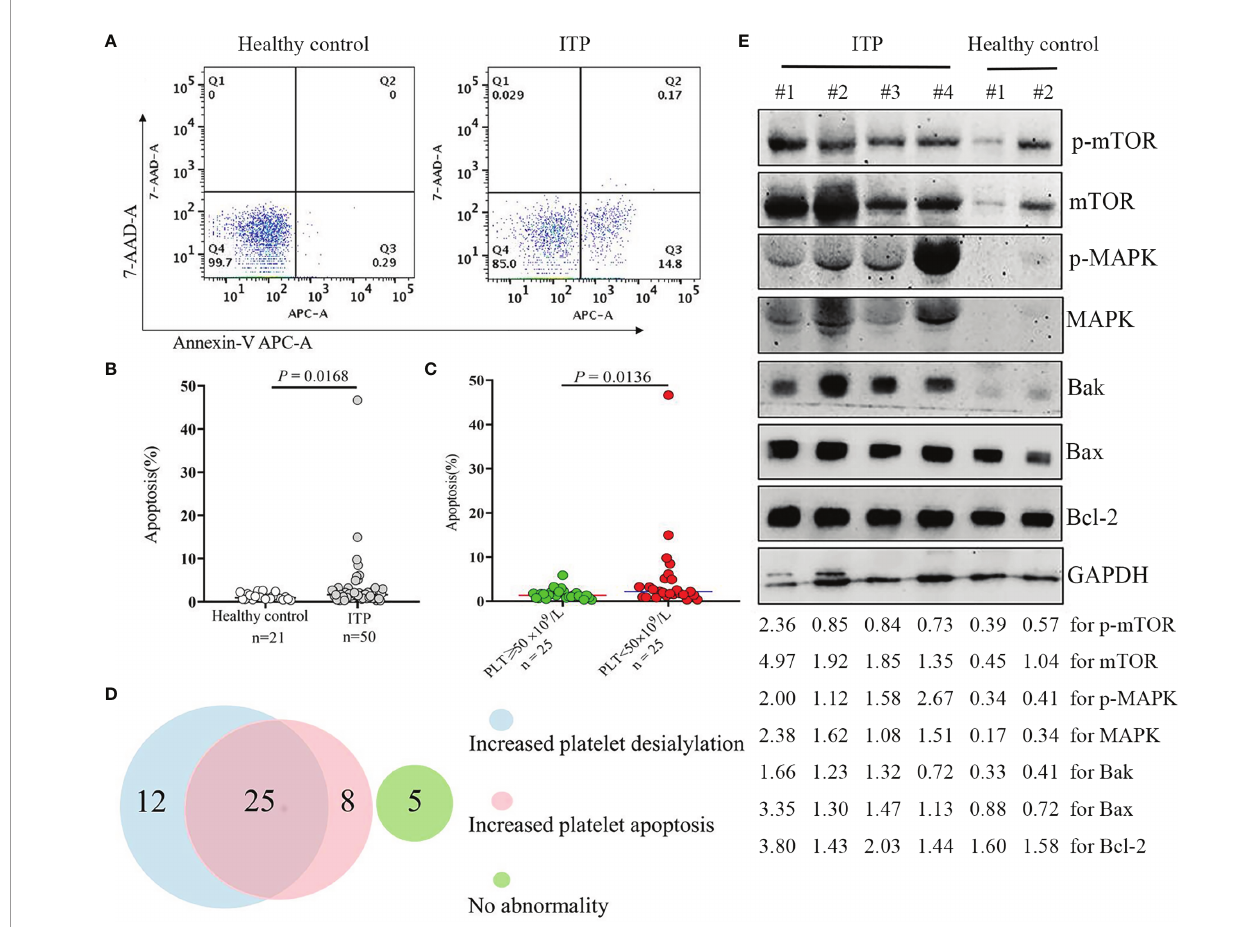
FIGURE 5 | Platelet apoptosis in the ITP cohort. Apoptotic platelets were stained with Annexin V-APC/7-AAD, and analyzed by fl ow cytometry. (A) The representative dot plots from healthy controls and ITP groups are shown. (B) Comparison of platelets undergoing apoptosis in healthy controls and patients with ITP. The P- value was calculated using the Mann-Whitney test. (C) Comparison of apoptotic platelet levels in ITP patients with different platelet count. (D) Venn diagram showing the numbers of patients presenting with increased platelet apoptosis and/or increased platelet desialylation. (E) Protein extracts from isolated platelet lysate were subjected to Western blotting using phosphorylated mTOR and MAPK, total mTOR and MAPK, pro-apoptotic Bak and Bax, anti-apoptotic Bcl-2, and GAPDH antibodies. Four representative samples from ITP patients and two representative samples from healthy volunteers are shown. The intensity of different protein bands was quanti fi ed and normalized with GAPDH. Relative intensity of p-mTOR, mTOR, p-MAPK, MAPK, Bak, Bax and Bcl-2 is depicted by the lower set of